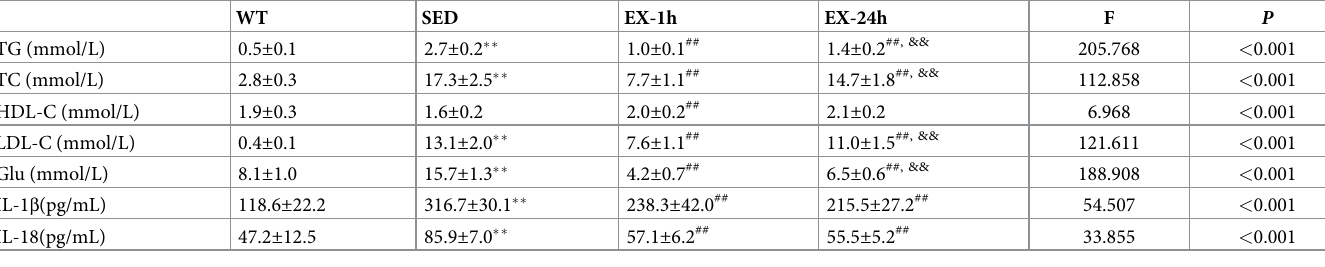
Table 2. Effects of aerobic exercise on blood glucose, lipids and inflammation levels.